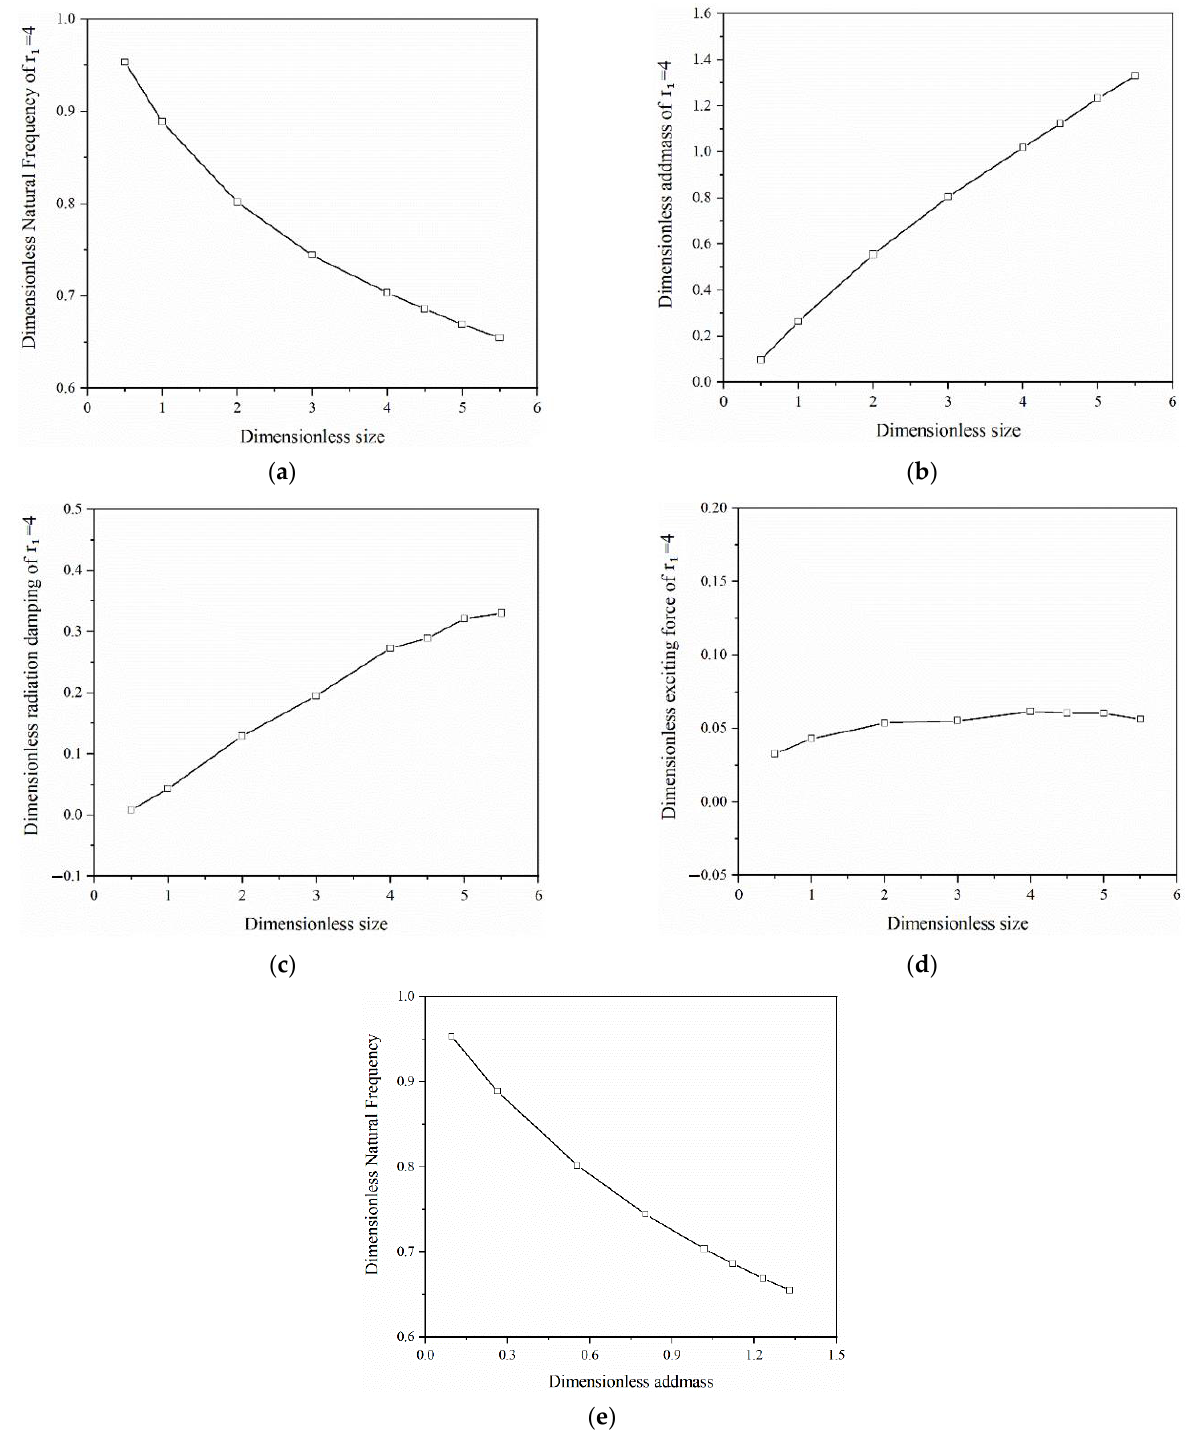
Figure 4. Variation of WEC dimensionless parameters. ( a ) Natural frequency. ( b ) Added mass. ( c ) Radiation damping. ( d ) Wave excitation force. ( e ) Natural frequency-added mass. To verify this relationship, five groups of different inner radii were taken at the same time to study the relationship between ds , dimensionless natural frequency, and added mass under different inner radii. As shown in Figure 5, the dimensionless natural fre- quency and added mass under different inner radii, show good consistency, which veri- fies this dimensionless process.